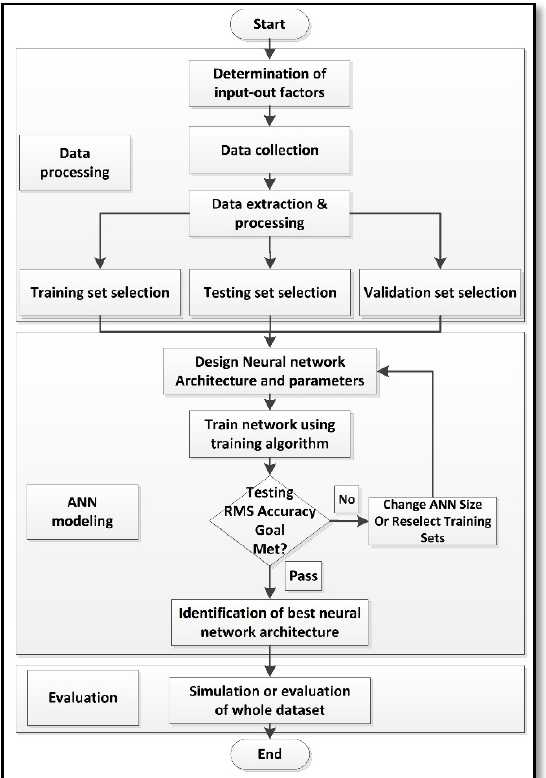
Figure 2. General stages of the ANN framework 3.